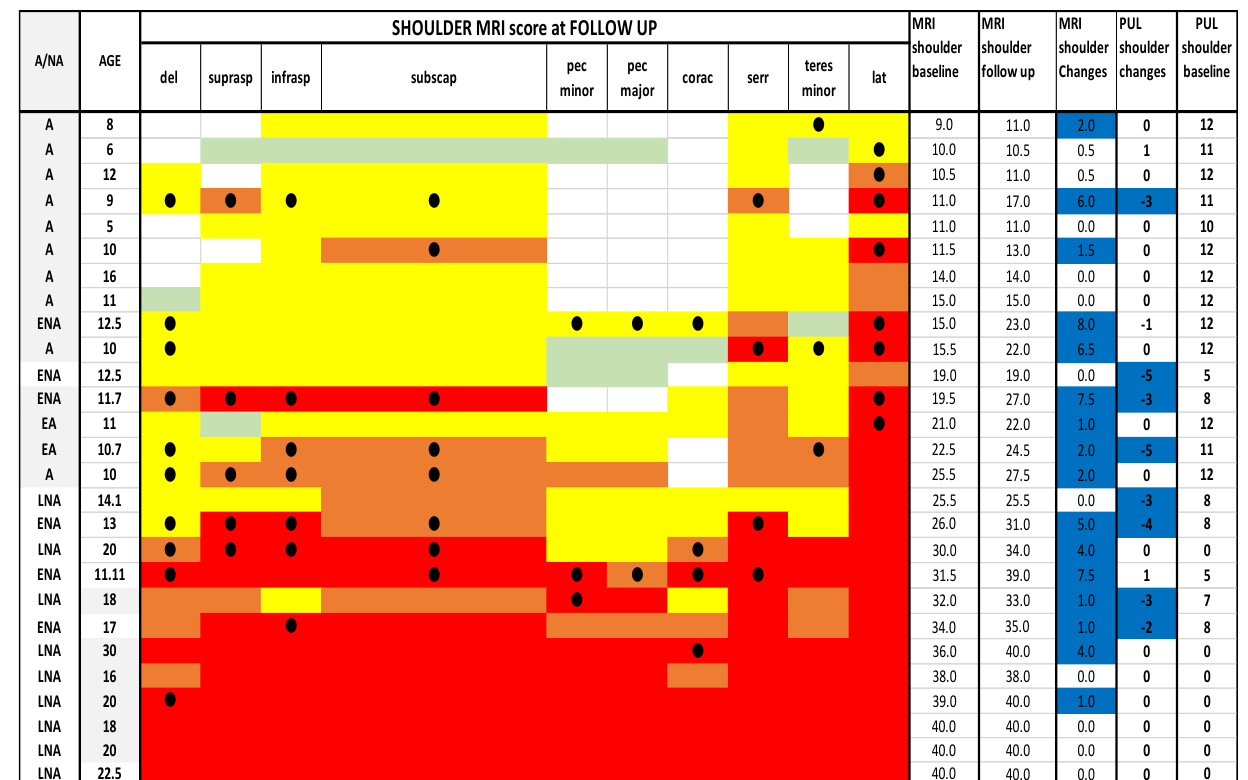
Figure 4. showed scores in muscle MRI at shoulder level at baseline and at follow up according to the age.